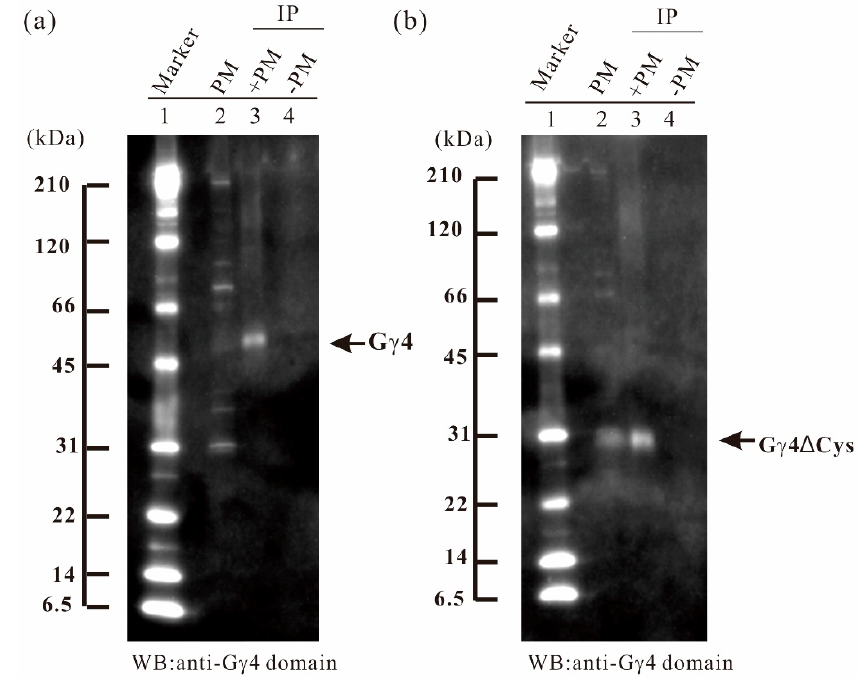
Figure 3. Immunoprecipitation (IP) of G γ 4 and G γ 4 Δ Cys candidates in leaf sheath of wild type (WT) and Dn1-1. ( a ) IP of G γ 4 candidate from solubilized plasma membrane proteins of wild type (WT) using anti-G γ 4 domain antibody. Lane 1, molecular weight markers; lane 2, 10 μ g of plasma membrane protein fraction of WT; lane 3, IP product of solubilized plasma membrane proteins and anti-G γ 4 domain antibody; lane 4, control experiment (buffer in the placement of membrane proteins). ( b ) IP of G γ 4 Δ Cys candidate from solubilized plasma membrane proteins of Dn1-1 using anti-G γ 4 domain antibody. Lane 1, molecular weight markers; lane 2, 10 μ g of plasma membrane protein fraction of Dn1-1 ; lane 3, IP product of solubilized plasma membrane proteins of Dn1-1 and anti-G γ 4 domain antibody; lane 4, control experiment (buffer in the placement of membrane proteins).